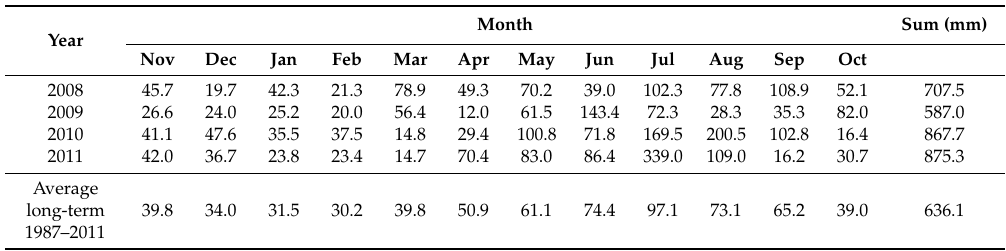
Table 2. Monthly and annual rainfall totals (mm) in the catchment in Wielkopole in the hydrological years 2008–2011 and average values from